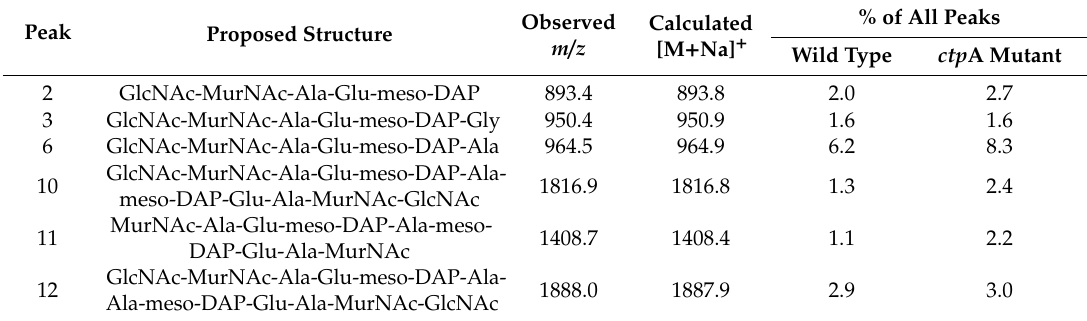
Table 1. Structures, molecular masses, and quantities of muropeptides from Rhizobium leguminosarum bv. viciae 3841 and ctpA mutant